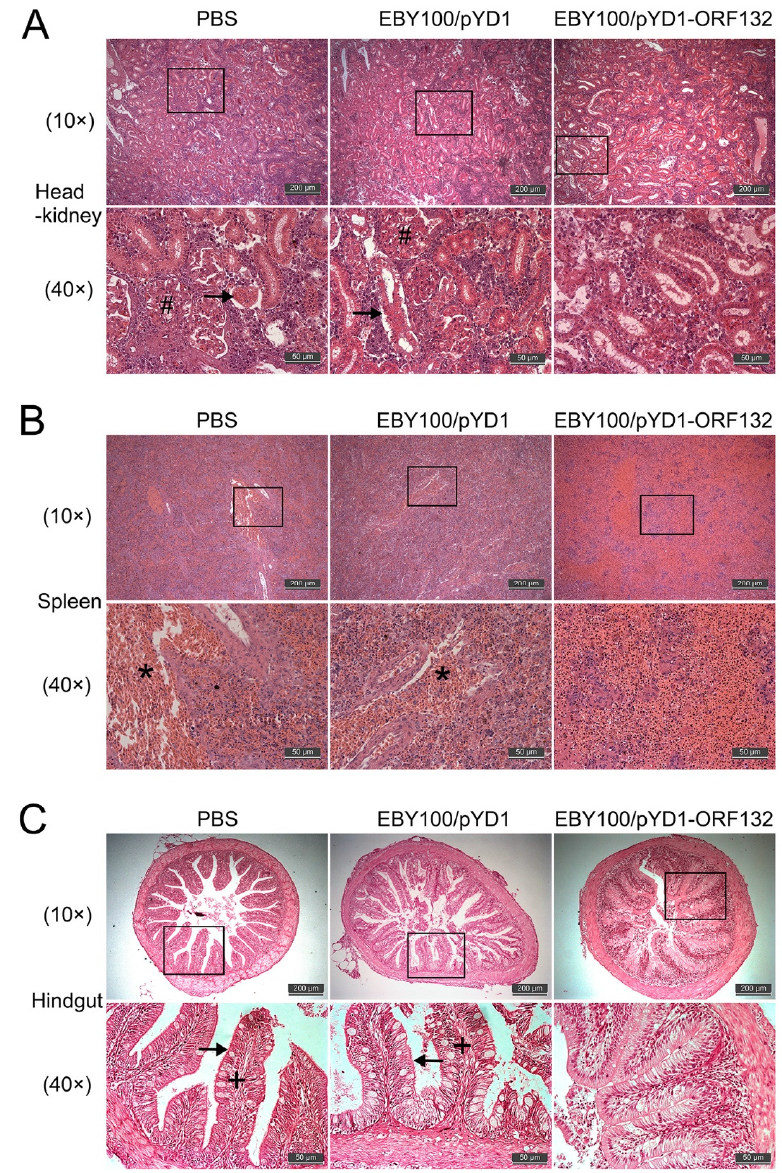
Figure 7. Histopathology analyses of head–kidney, spleen, and hindgut. Head–kidney ( A ), spleen ( B ), and hindgut ( C ) was performed for histopathological analysis. Organize shrinking (arrow), necrosis (#), diffuse congestion (*), and increase in goblet cells (+). Scale bar = 50 μ m or 200 μ m.